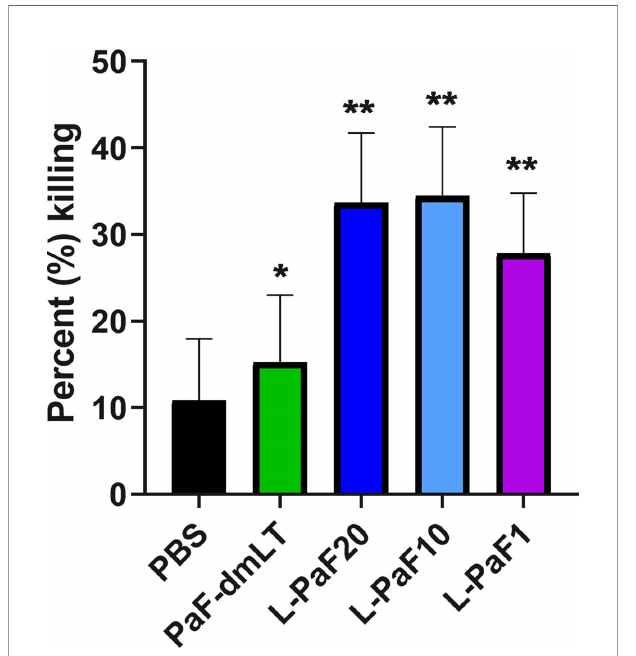
FIGURE 9 | Opsonophagocytic killing (OPK) activity of serum samples. Pooled sera from each vaccinated mouse group (5 µl/mouse) were tested for their OPK activity after heat-inactivation. The sera were combined with mPA08-31 and J774A.1 cells at an MOI of 0.1. Killing was determined using (T 0 -T 30 )/T 0 x100. This is a representative experiment of quadruplicates for each sample. **p < 0.005 and *p < 0.01 for respective groups were compared to PBS using a two-way ANOVA.